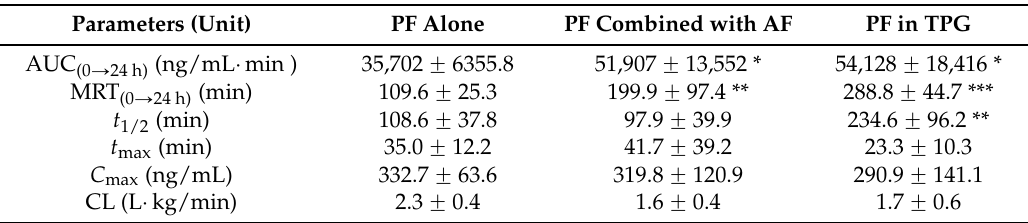
Table 2. The main pharmacokinetic parameters of PF with three different forms in rat plasma after intragastrical administration ( n =